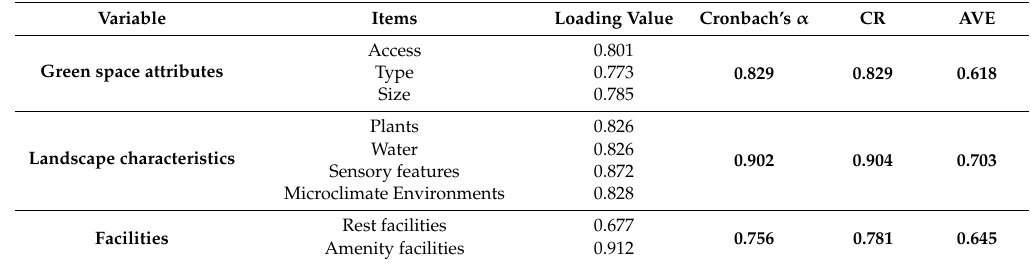
Table 1. Reliability and validity